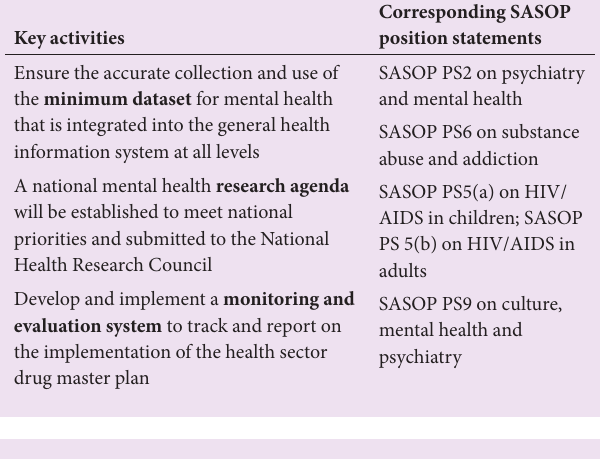
Table 3. Objective 3: Surveillance, research and innovation